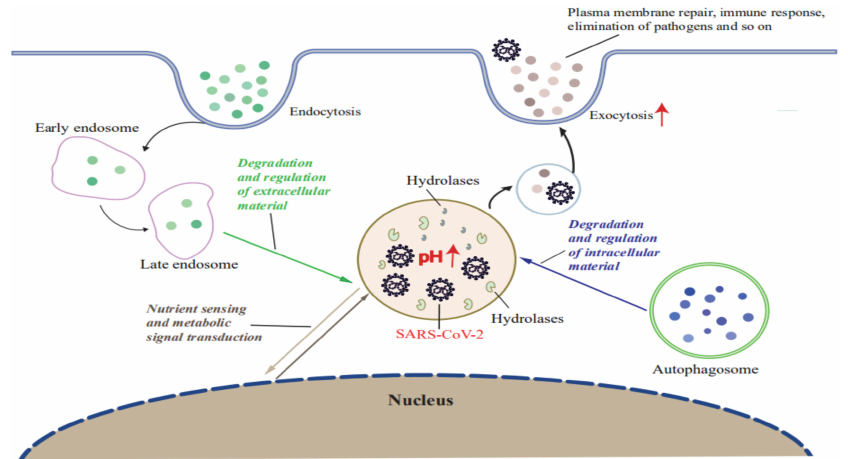
Figure 2. SARS-CoV-2 infection induces lysosomal dysfunction. SARS-CoV-2 infection leads to lysosome deacidification and promotes lysosomal exocytosis. SARS-CoV-2-hijacked lysosomes partic- ipate in the degradation and recycling of intracellular and extracellular material through autophagy and endocytosis to provide energy and source molecules. Exocytosis of SARS-CoV-2-hijacked lyso- somes contributes to PM repair, the immune response, pathogen elimination, and progeny virus release in stores. SARS-CoV-2-hijacked lysosomes sense nutrients and activate metabolic signal trans-